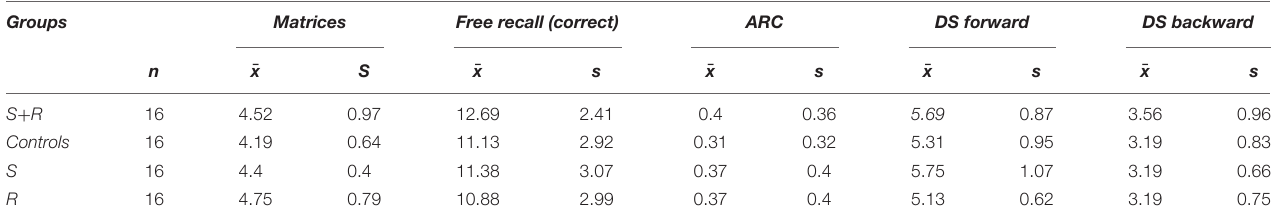
TABLE 1 | Group means for pretest measures. Groups